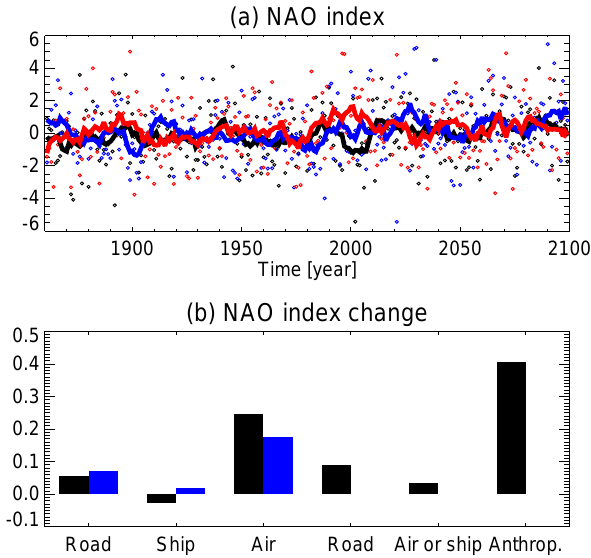
Fig. 17. (a) Mean NAO anomalies calculated from sea level pres- sures taking into account the total anthropogenic impact (the dif- ferent colors indicate the 3 simulations of the ensemble). Single dots indicate yearly values, and lines show 11-yr running averages. (b) Impact of the transport sectors on the NAO anomaly averaged over 2050–2099. The first three bars show the non-CO 2 (black) and non-CO 2 * (blue) impacts, the following two the CO 2 impacts, and the last one the total anthropogenic impact.